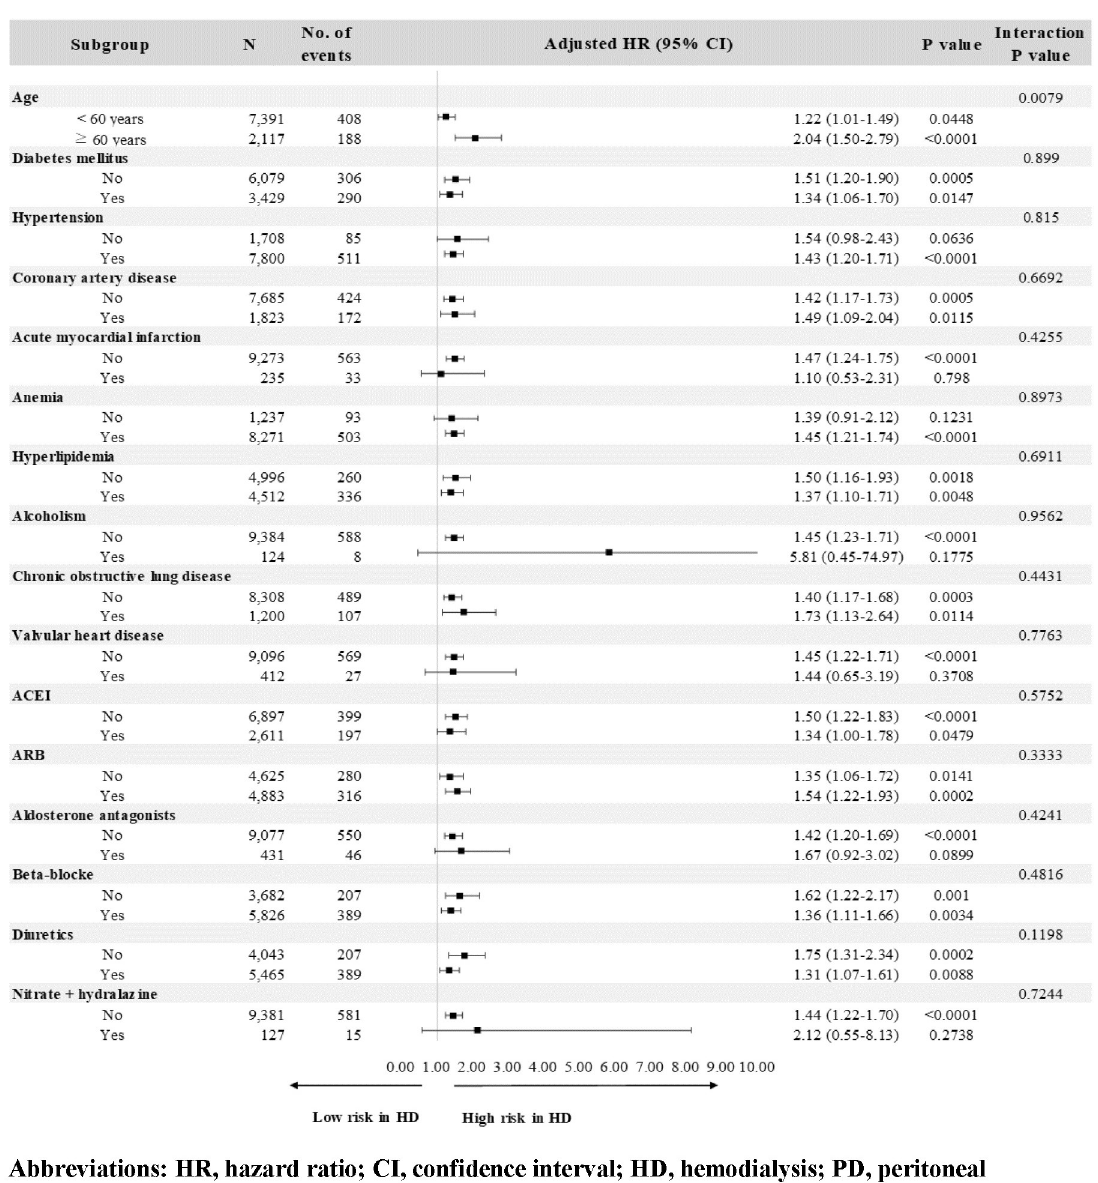
Fig 3. Stratified analysis of risk for CHF between matched pairs of hemodialysis and peritoneal dialysis patients using multivariable subdistribution hazard